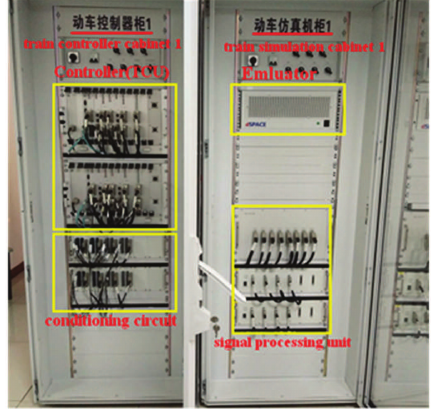
Figure 18. The physical diagram of the simulation